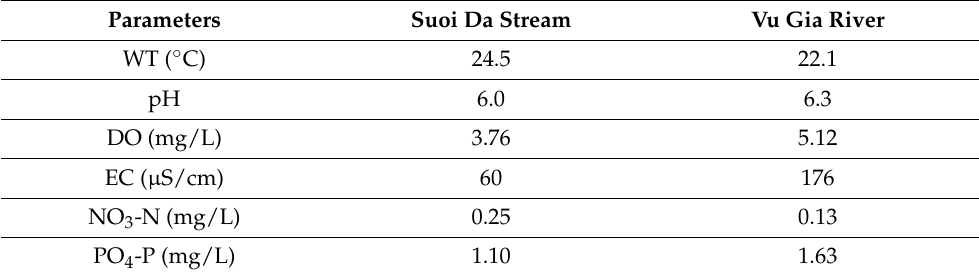
Table 2. Environmental parameters in a hyporheic zone of two rivers in the central Vietnam in June 2019. Parameters Suoi Da Stream Vu Gia